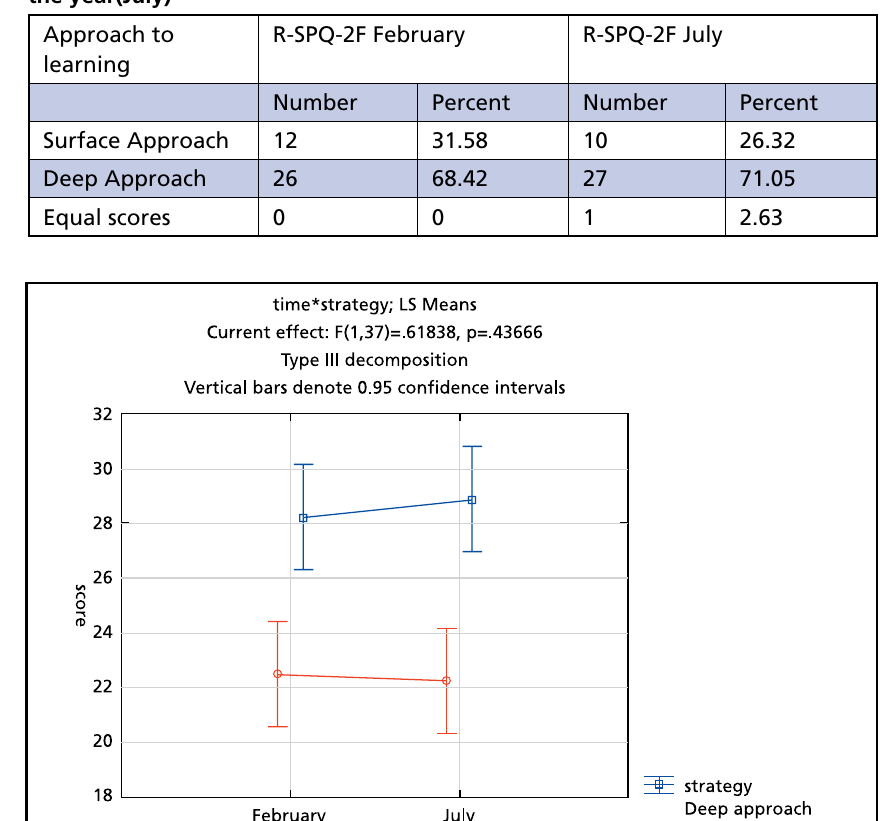
table 2: approaches toward learning at the beginning (February) and middle of